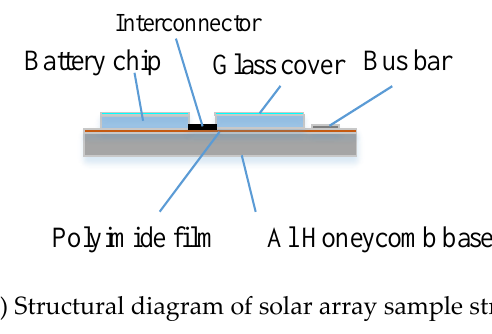
Figure 3. Solar array test sample.